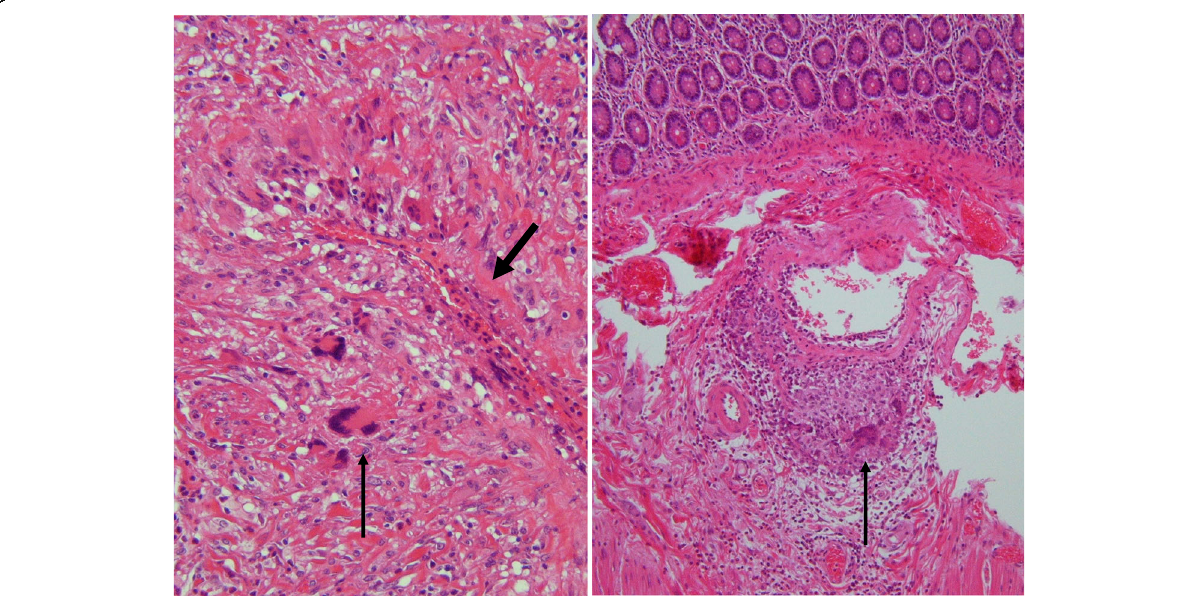
Fig. 3 Histological examination in the area of the vein (left) and small intestine (right). The thickening wall of the vein is remarkable (thick arrow). Granulomatous infiltration of lymphocyte, neutrophils, and eosinophils as well as multinucleated giant cells (thin arrow) is viewed in both